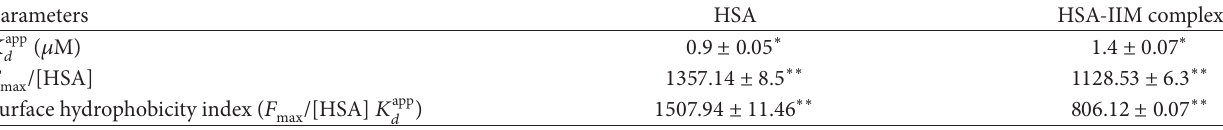
Table 3: Surface hydrophobicity parameters for HSA in the absence and the presence of isoimperatorin.